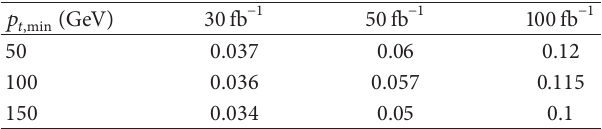
Table 1: The SM event numbers of 𝑝𝑝 → 𝑝𝑞𝑞𝑝 process for different values of 𝑝 𝑡 transverse momentum cuts (𝑝 𝑡, min ) and luminosities. Here, acceptance region is taken to be 0.0015 < 𝜉 < 0.15 .